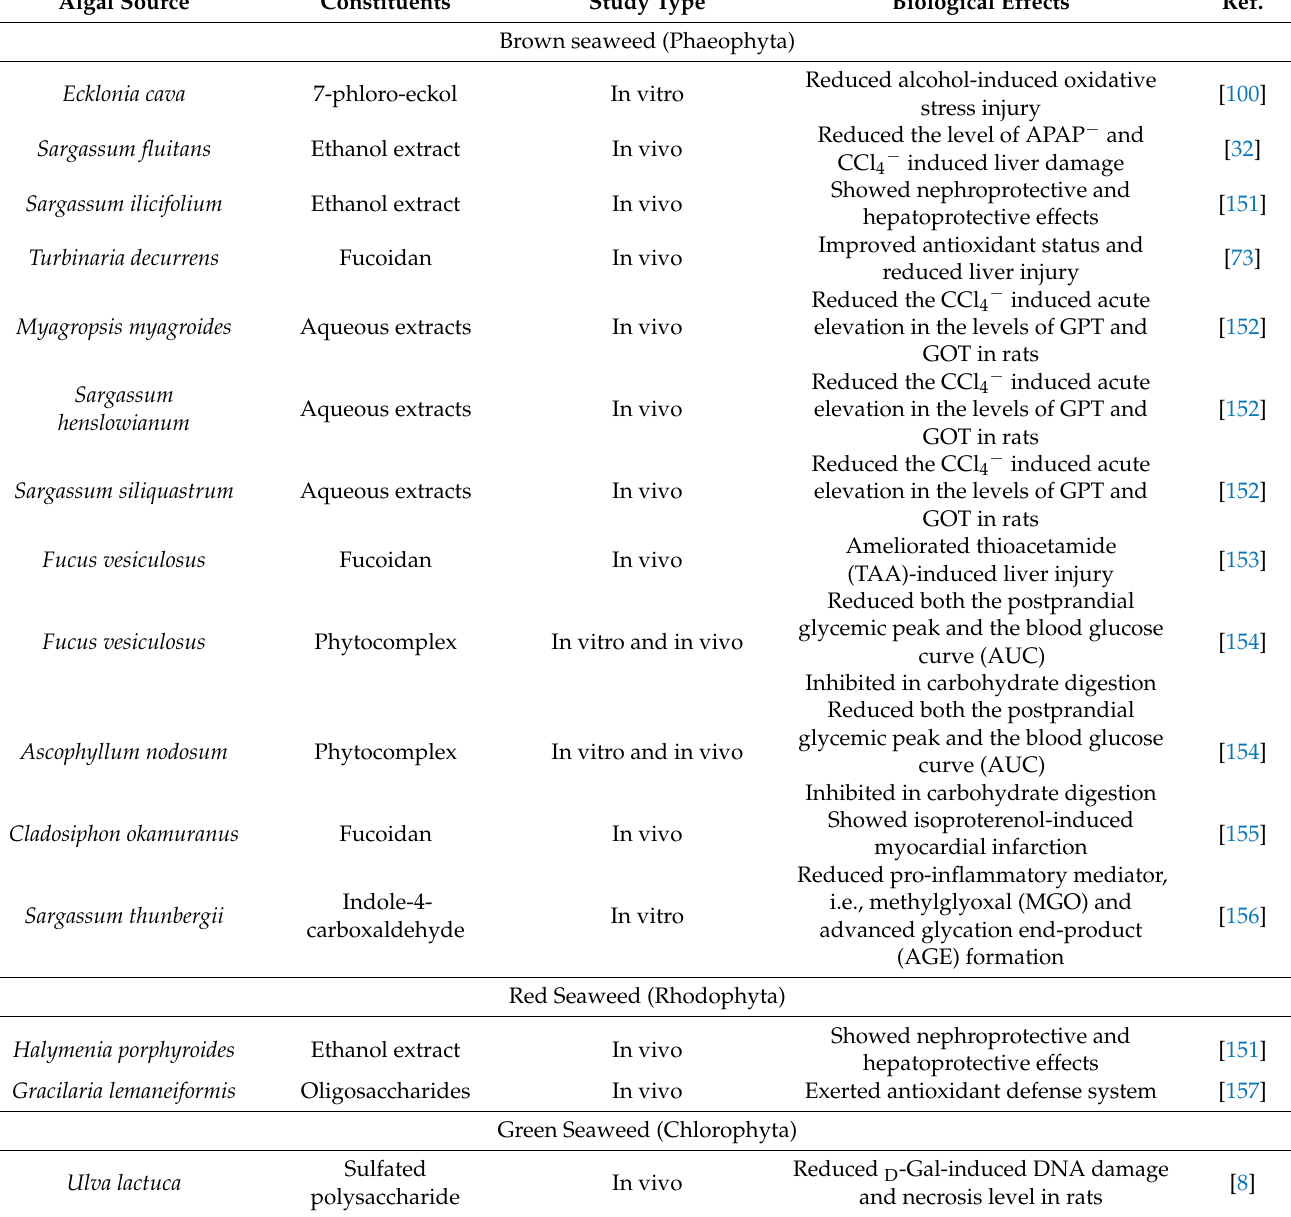
Table 3. The effects of seaweed-derived compounds on liver